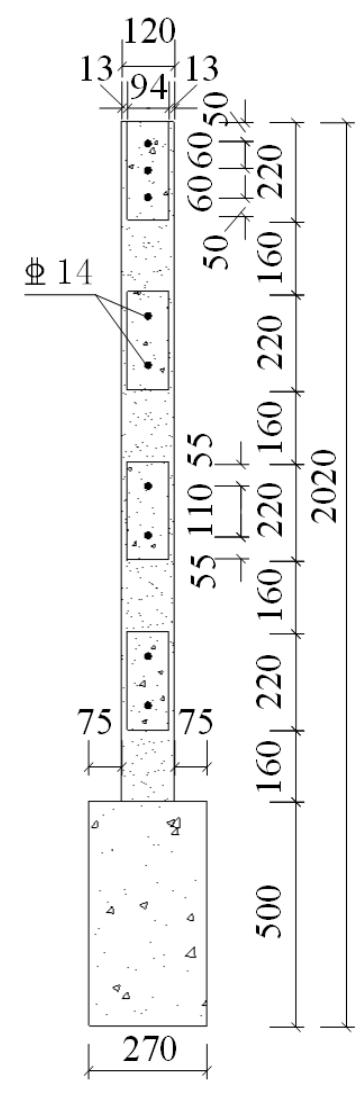
Figure 5. Side elevation of CIW